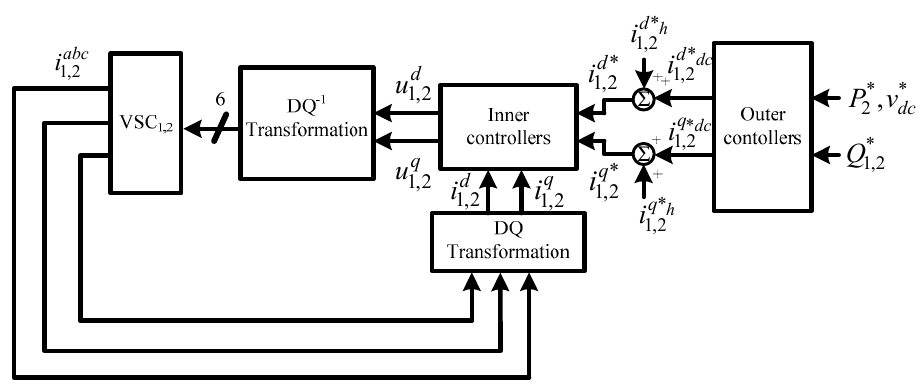
Figure 4. General block diagram for the BTB-VSC.